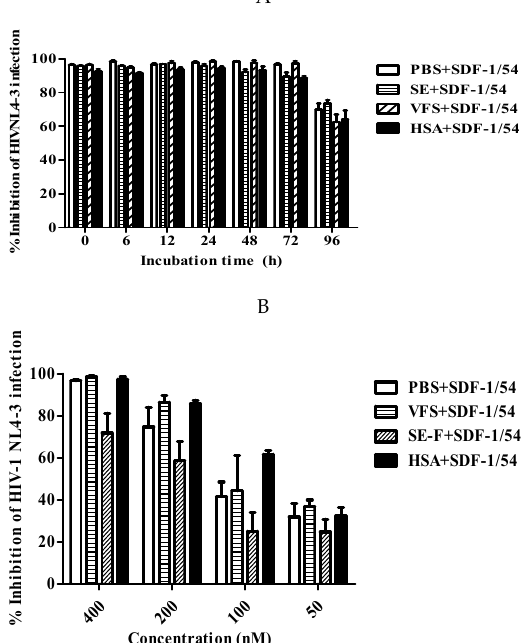
ff ects of human SE-F, VFS and HSA on the anti-HIV-1 stability and activity of Figure 8. The effects of human SE-F, VFS and HSA on the anti-HIV-1 stability and activity of SDF- Figure 8. The e SDF-1 / 54. SDF-1 / 54 was incubated with PBS, VFS, SE-F and HSA (45mg / mL) for various time period. The remaining anti-viral activities of SDF-1 / 54 were tested ( A ). In addition, di ff erent concentrations of SDF-1 / 54 maintained antiviral activity in the presence or absence of SE, VFS and HSA ( B ), which were determined using p24 ELISA assay. Averages ( ± SD) from three independent experiments are